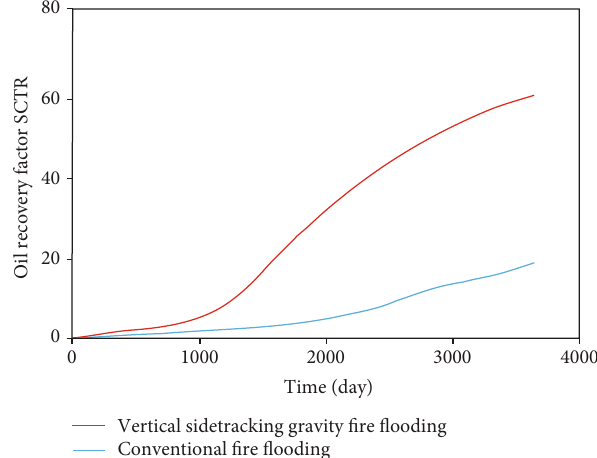
Figure 5: Comparison of recovery degree between conventional fi re fl ooding and vertical sidetracking gravity fi re fl